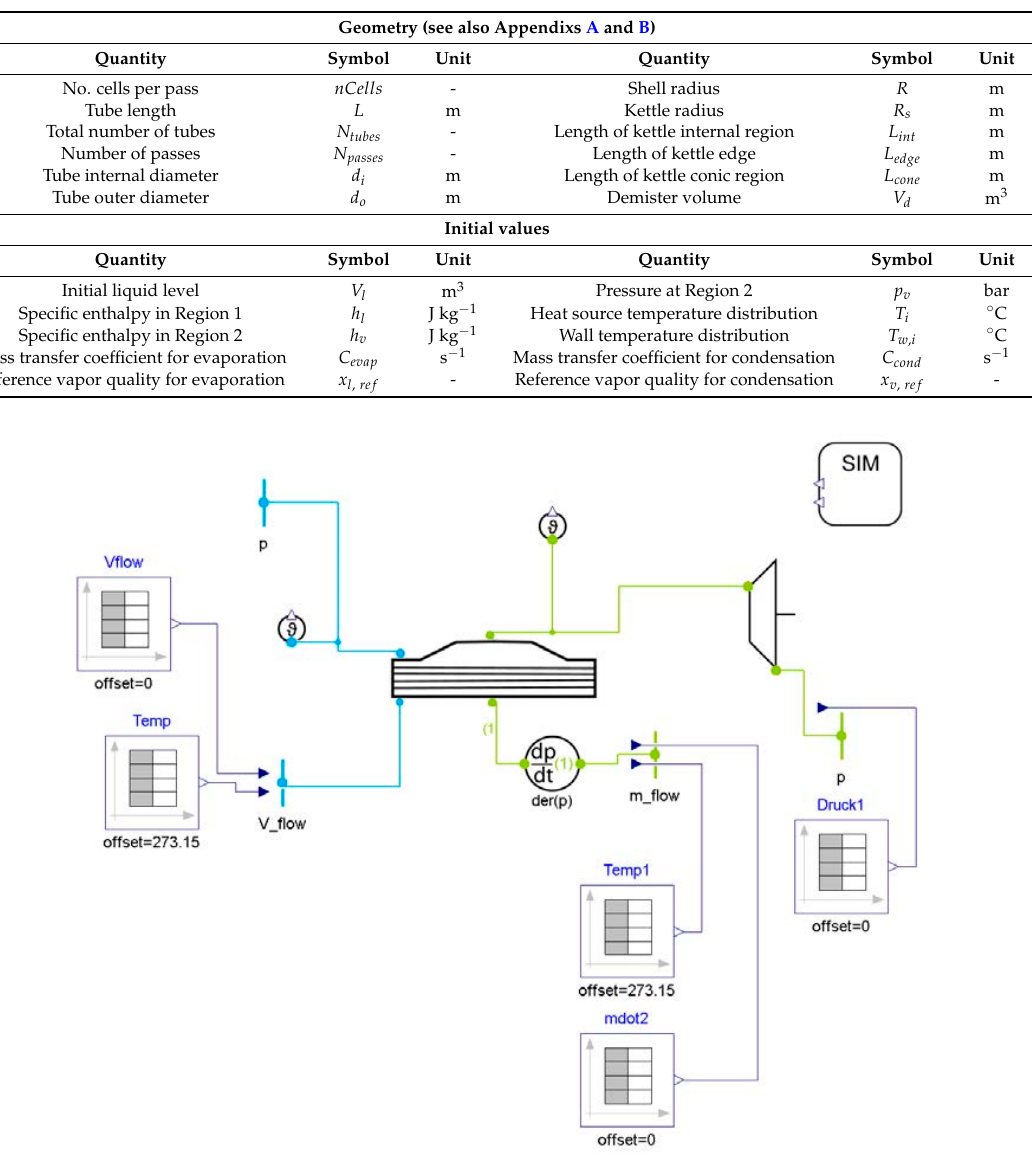
Table 3 . Parameters and initial value for kettle boiler model.